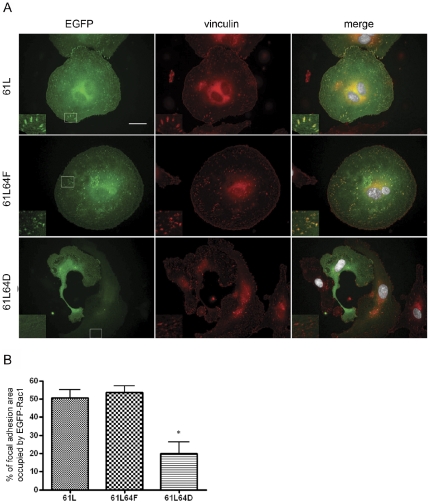
Y64 phosphorylation modulated focal adhesion targeting of active Rac1.(A) HUVEC cells were transfected with EGFP-tagged Rac1 mutants including Rac1-61L, Rac1-61L64F and Rac1-61L64D. Cells were labeled with DAPI and anti-vinculin (followed by Cy5). Transfected EGFP-positive cells are shown in green, while the vinculin labeled focal adhesions shown in red. The composite images display merges of combined GFP (green), DAPI (white), and vinculin (red) labeling. The boxed areas were magnified (2X) and shown in the insets. Scale bar denotes 30 µm. (B) The percentage of the total focal adhesion area (defined by vinculin labeling) that was occupied by EGFP-tagged Rac1 mutants in transfected cells were quantified using Openlab software. Fifteen randomly picked transfected cells were analyzed in each group, and data are shown as the mean±SD. * denotes p < 0.05 when data from groups transfected with 61L/64F or 61L/64D are compared with values from the group transfected with 61L alone.